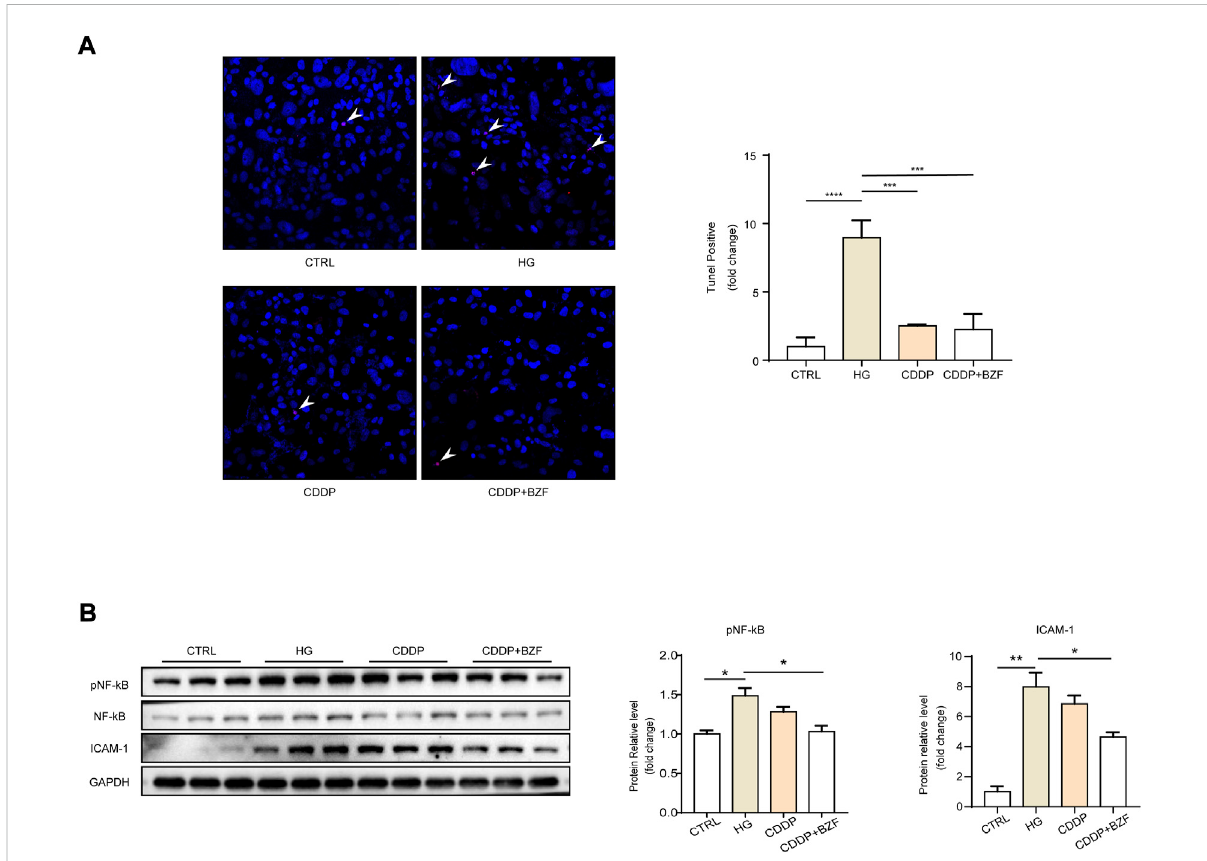
FIGURE 3 Coadministration of CDDP and BZF inhibited apoptosis and had better anti-in fl ammatory effects than monotherapy. (A) TUNEL positive cell image and its statistical chart ( n = 5) and (B) cell western blot images and statistical charts ( n = 3). Unpaired t -test. * p < 0.05, ** p < 0.01, *** p < 0.001, **** p < 0.0001. CTRL: control; HG: